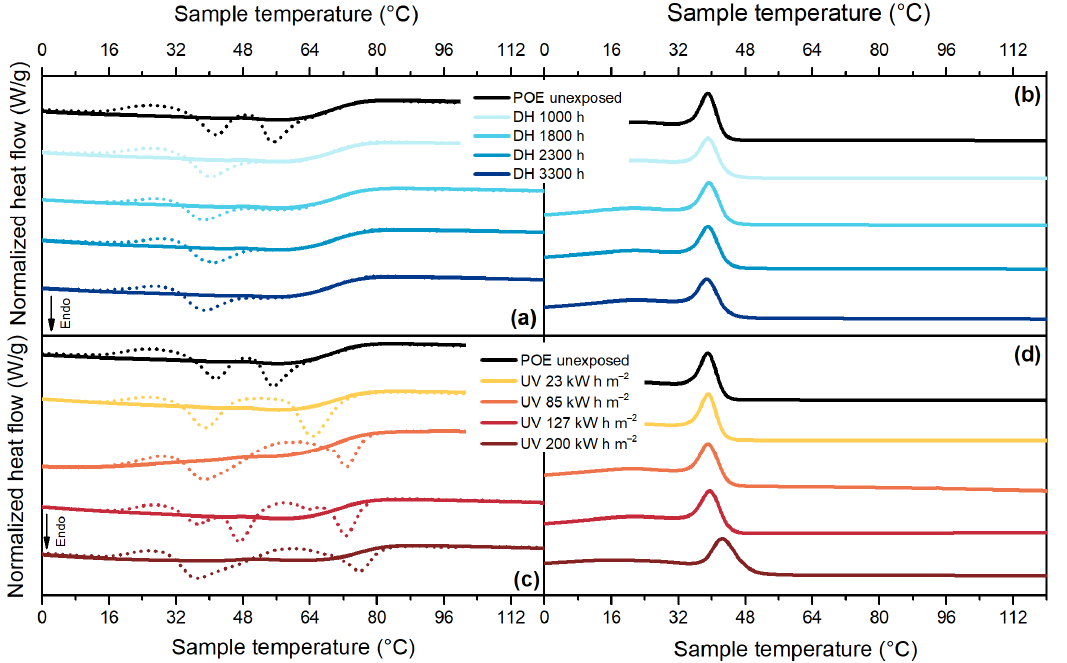
Figure 11. DSC thermograms for POE. First heating curves (dashed lines) and second heating curves (full lines) from samples exposed to DH test ( a ). Cooling curves for samples exposed to DH test ( b ). First heating curves (dashed lines) and second heating curves (full lines) from samples exposed to UV test ( c ). Cooling curves for samples aged under UV test ( d ).